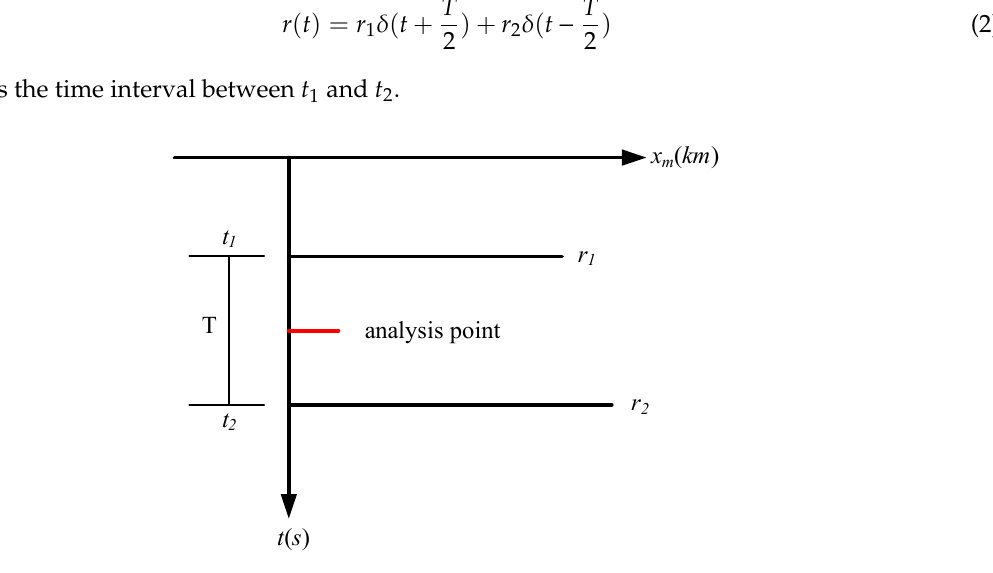
Figure 1. Three-strata layers model with two reflection surfaces.